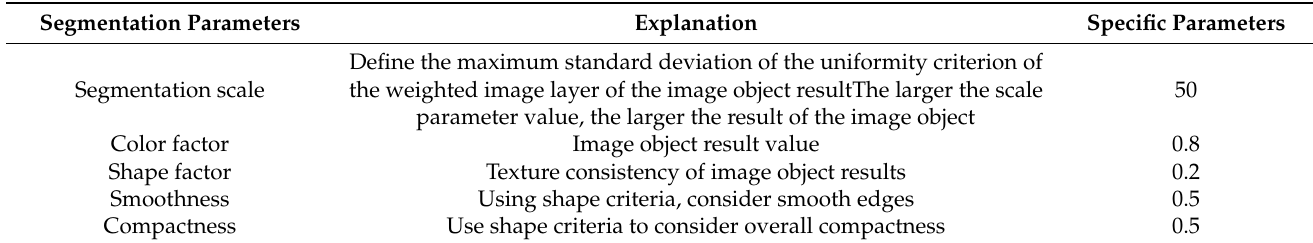
Table A2. Segmentation